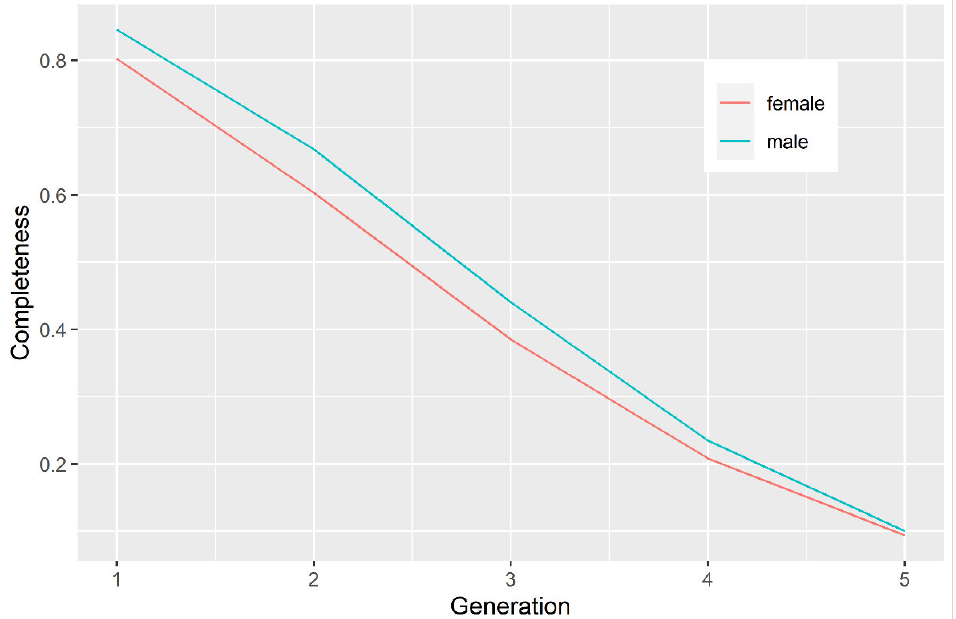
Figure 1. Completeness of the pedigree of Istrian sheep under the study.